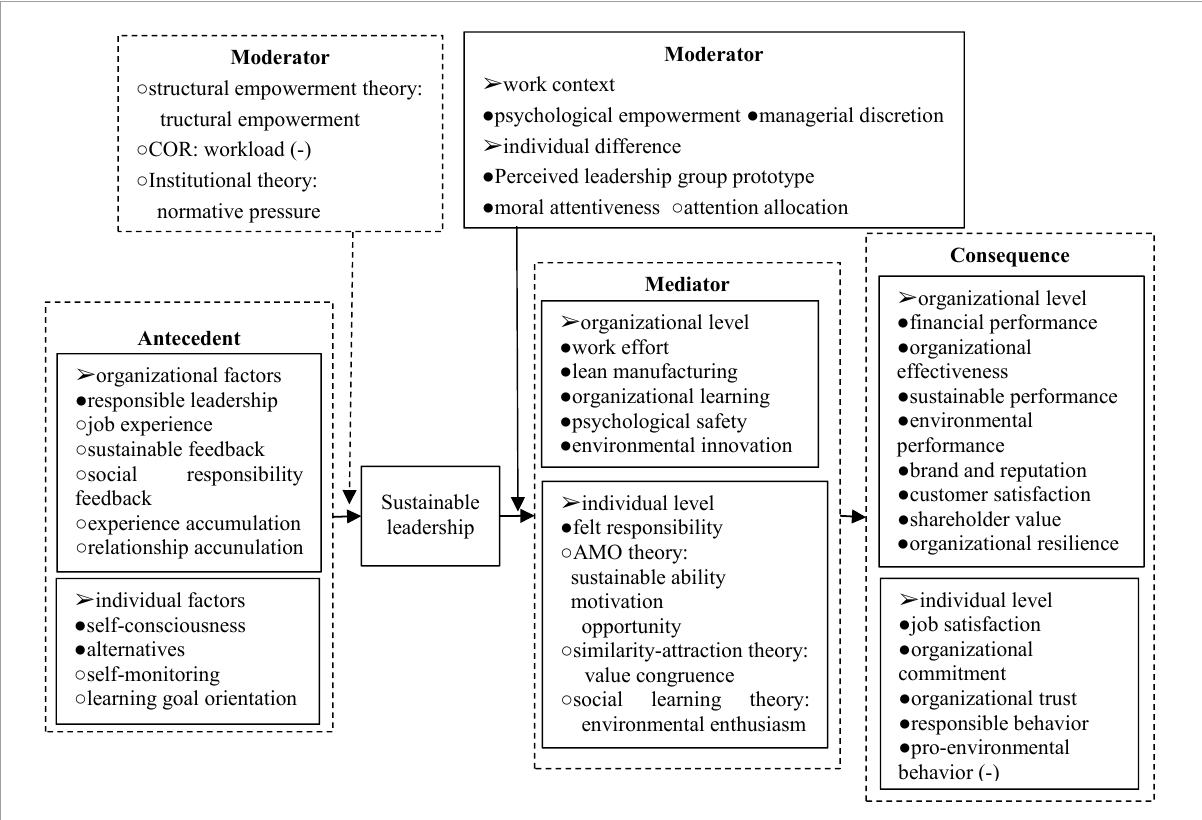
FIGURE1 The analysis framework for sustainable leadership. Solid arrows and “ • ” represent pathway relationships and variables explored by existing studies, dashed arrows and “ ◦ ” represent pathway relationships and variables proposed by research outlooks, and ( − ) indicates negative